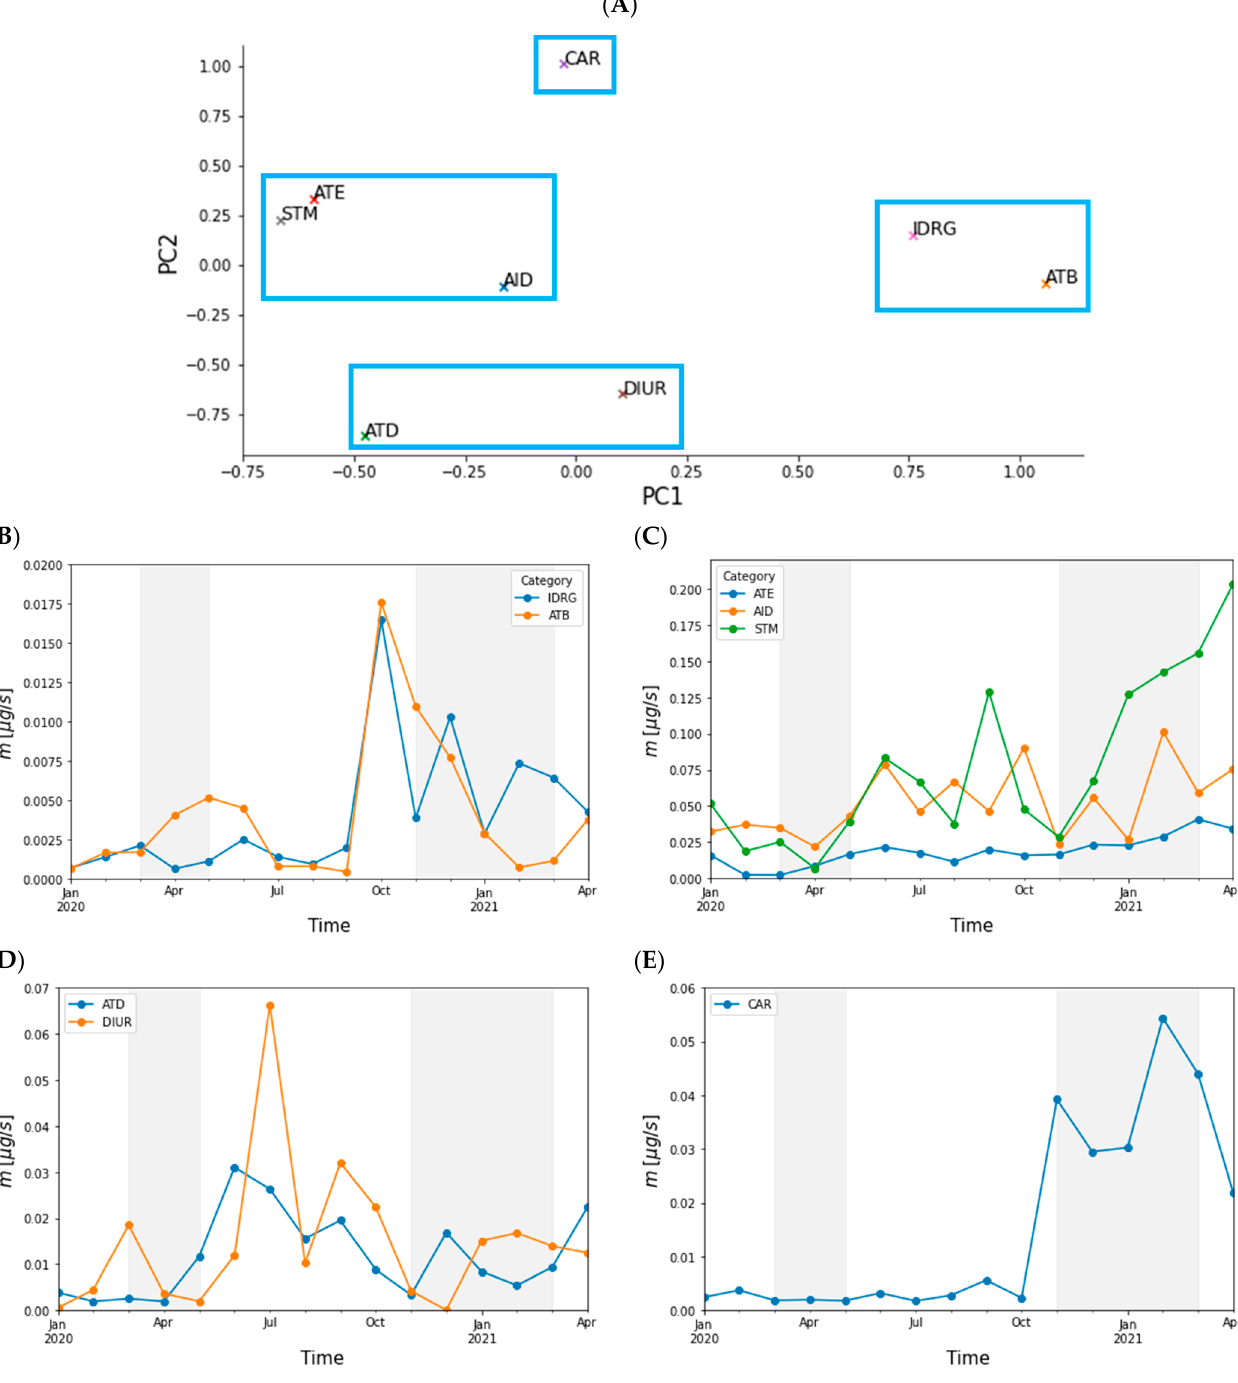
Figure 5. ( A ) PCA scores plot of the summed PhACs/IDrgs grouped by category; ( B – E ) from the PCA recovered categories (blue rectangles) are plotted as time series according to their position in the PCA, i.e., similarity of the time ‐ based patterns. The grey areas represent periods of lockdowns.